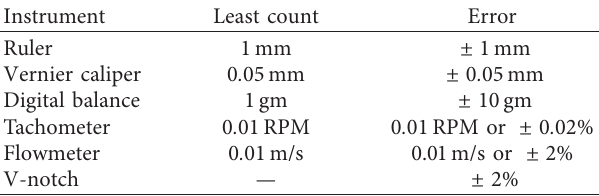
Table 2: Accuracy of measuring instrument.